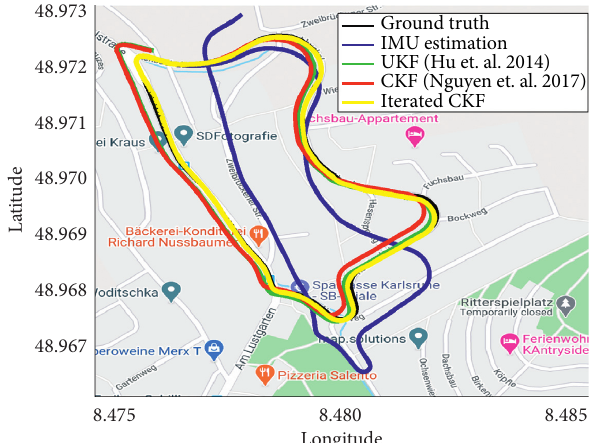
Figure 11: Experimental results presented in Google Maps for dataset 2011_09_30_0033.